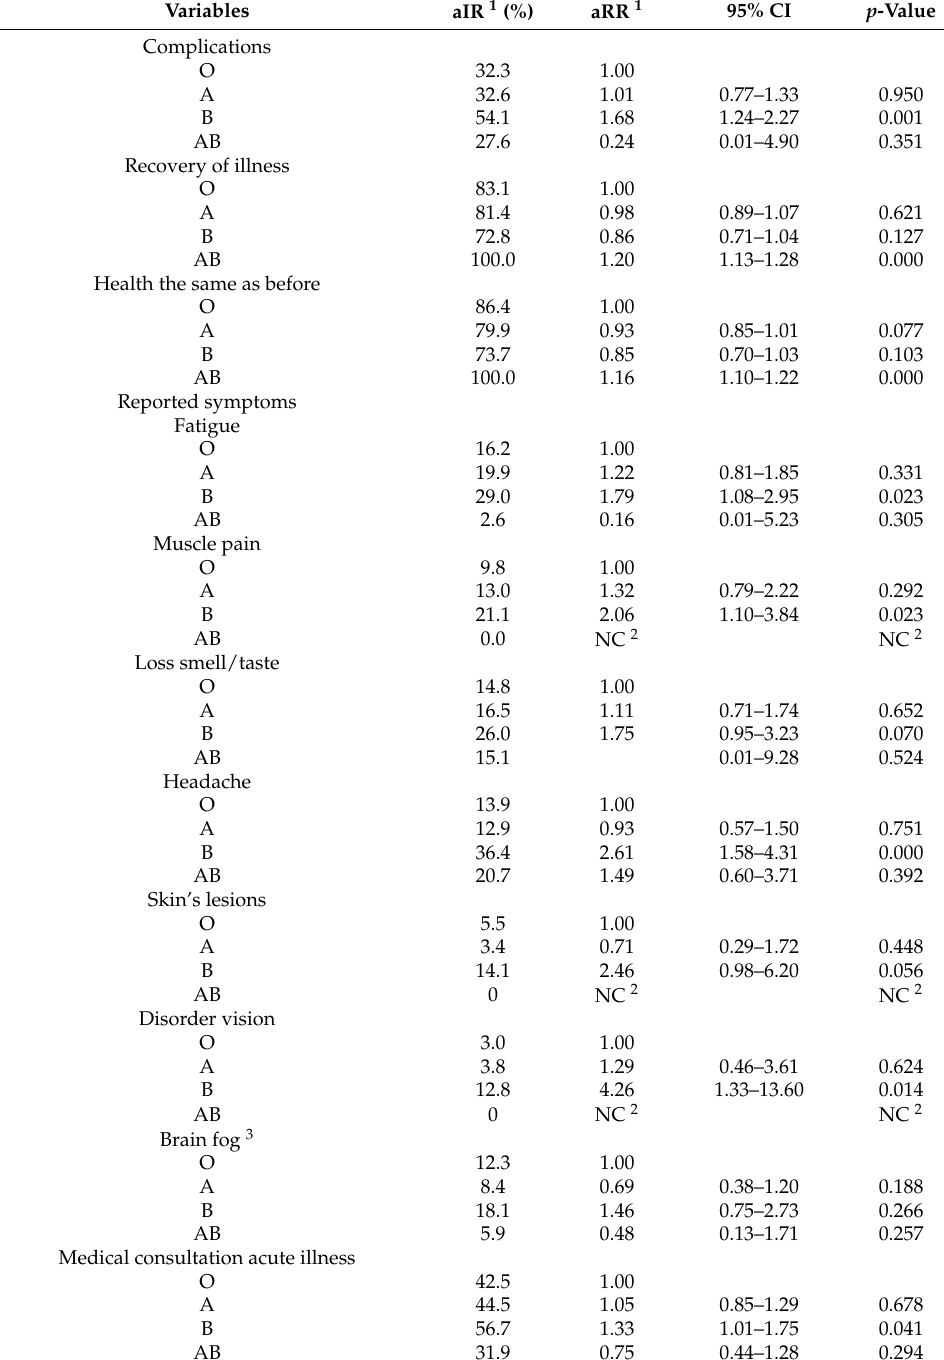
Table 5. Adjusted incidence rate (aIR), adjusted relative risk (aRR), and 95% confidence interval (CI) by inverse probability weight regression of complications, and reported symptoms of ABO blood groups. Borriana COVID-19 cohort 2020.